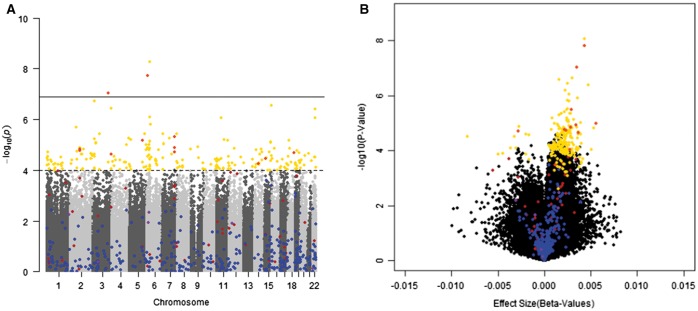
distribution of age-associated markers in study population. (A) Manhattan plot of age-associated methylation markers in study population adjusted for BMI, urinary creatinine, and estimated white blood cell composition. Solid line denotes experimental epigenome-wide significance (P < 10e-7). Dashed line denotes nominal significance level, P < 10e-4. (B) Volcano Plot of adjusted age-associated markers. For both plots, blue denotes markers included in Horvath predictor, red denotes markers in Hannum predictor, yellow are those significant in our population, orange is the overlap between Hannum and our markers, and purple is the overlap between Horvath and Hannum